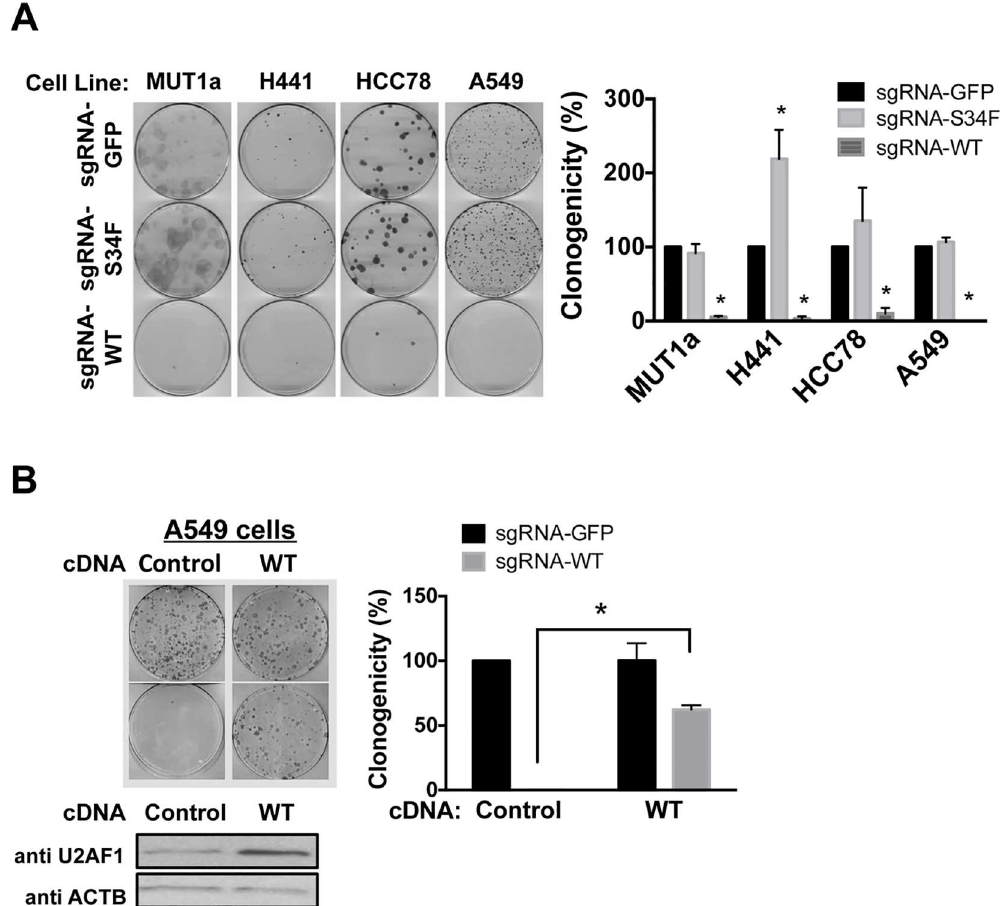
Fig 6. Wild-type but not mutant U2AF1 is required for the clonogenic growth of the isogenic HBEC3kt cells and LUAD cell lines. (A) . Clonogenic growth assays after selective disruptionof the wild-type or mutant U2AF1 allele. Left panel: The indicatedcell lines were transducedwith lentiviruses expressing Cas9 and sgRNA-GFP, sgRNA-S34F or sgRNA-WT, followedby clonogenicassays. Cell colonieswere stained with methylene blue and counted three weeks later. Right panel: Quantification of the clonogenicassay. The results are shown as percent clonogenicity by setting the number of control cell colonies(cells transduced with Cas9 and sgRNA-GFP) as 100%. Asterisks represent statistical significant changes as compared to Cas9 and sgRNA-GFP-transduced conditionin each cell line. Error bars represent s.e.m (n = 3). (B) . Rescue of growth inhibitionby Cas9 and sgRNA-WT by overexpressing a form of wild-type U2AF1 cDNA that is not predicted to be the target for sgRNA-WT (See S8 Fig and S1 Text). Left panel: A549 cells were transduced with a control (DsRed-Express 2) or a wild-type U2AF1 cDNA that is not predicted to be the target for sgRNA-WT. Increased expression of wild-type U2AF1 was confirmed by immunoblot(left bottom panel). These cells were subsequently transduced with Cas9 and either sgRNA-GFP or sgRNA-WT followedby clonogenic assays as in panel A (left upper panel). Right panel: Quantification as in Panel A. The asterisk represents a statistical significant change for the indicatedcomparison. Error bars represent s.e.m. (n =